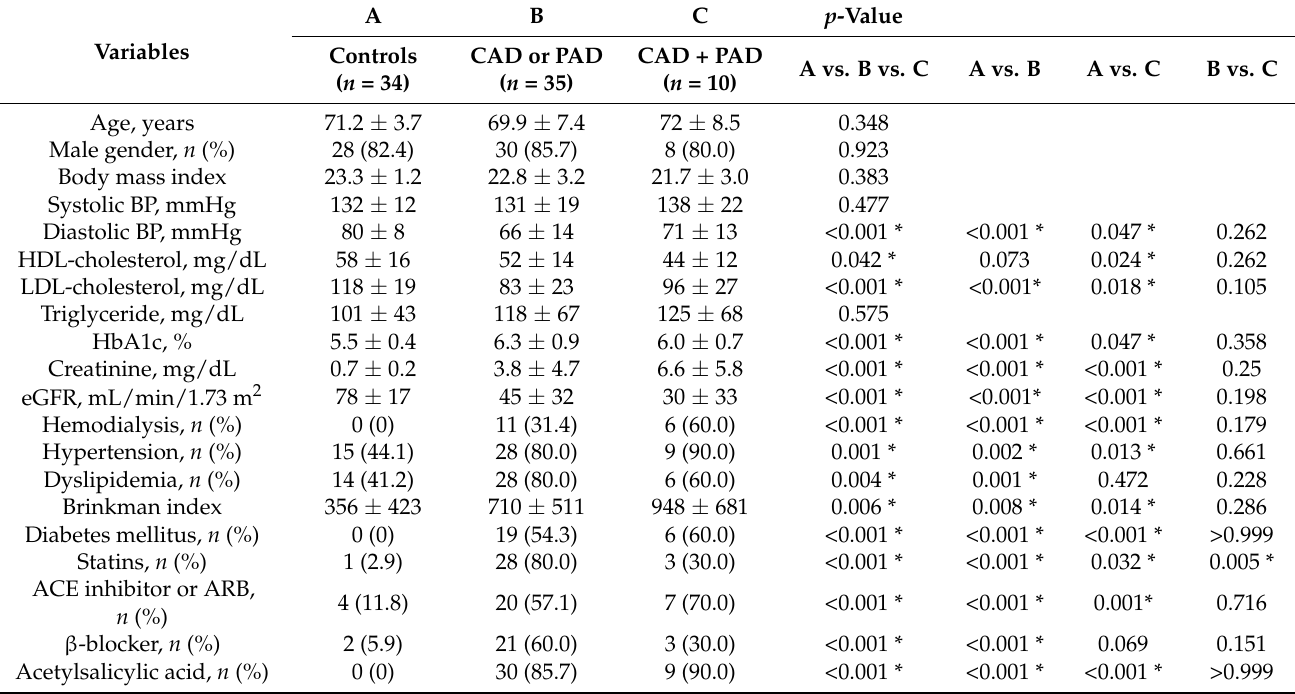
Table 1. Clinical baseline characteristics of patients with atherosclerosis and controls.